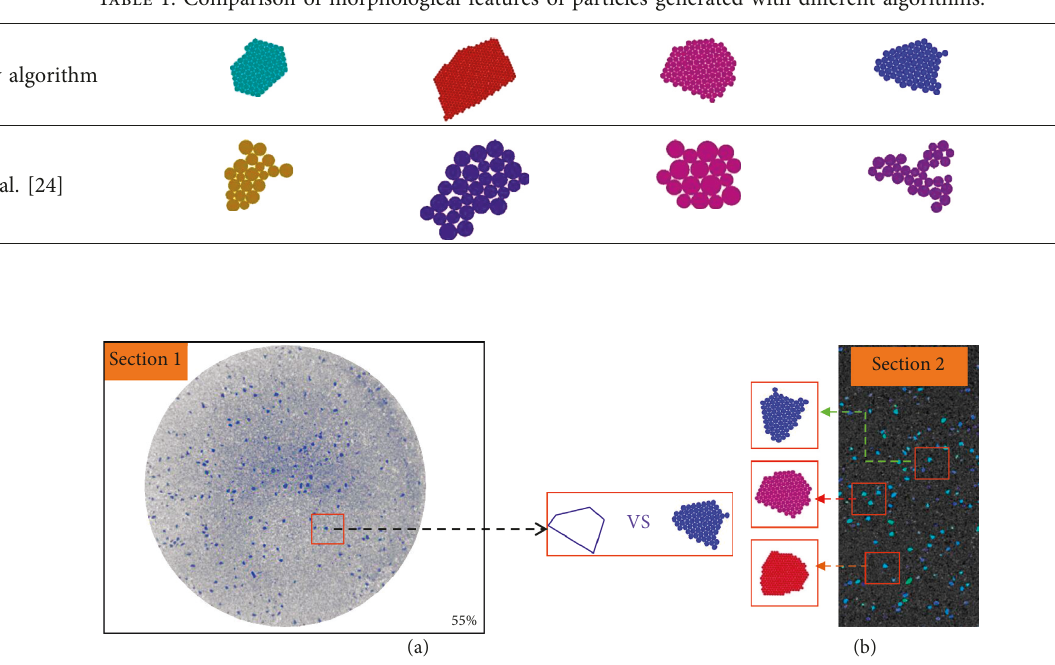
Figure 4: Comparison of cross-sectional characteristic features of calcite particles. (a) Cross Section. (b) Longitudinal